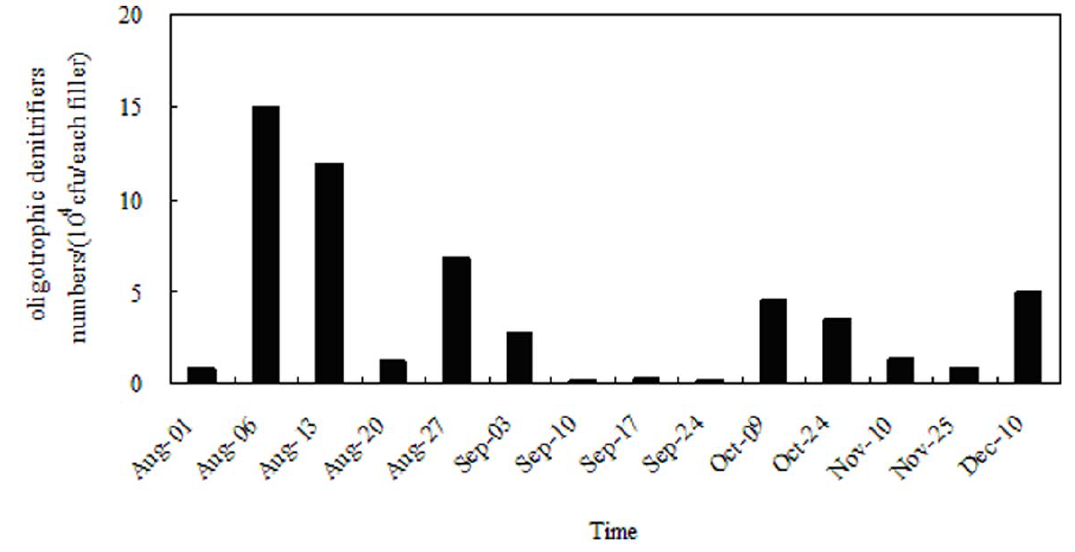
Figure 5. Changes of oligotrophic denitrifiers number on the fillers during operation.